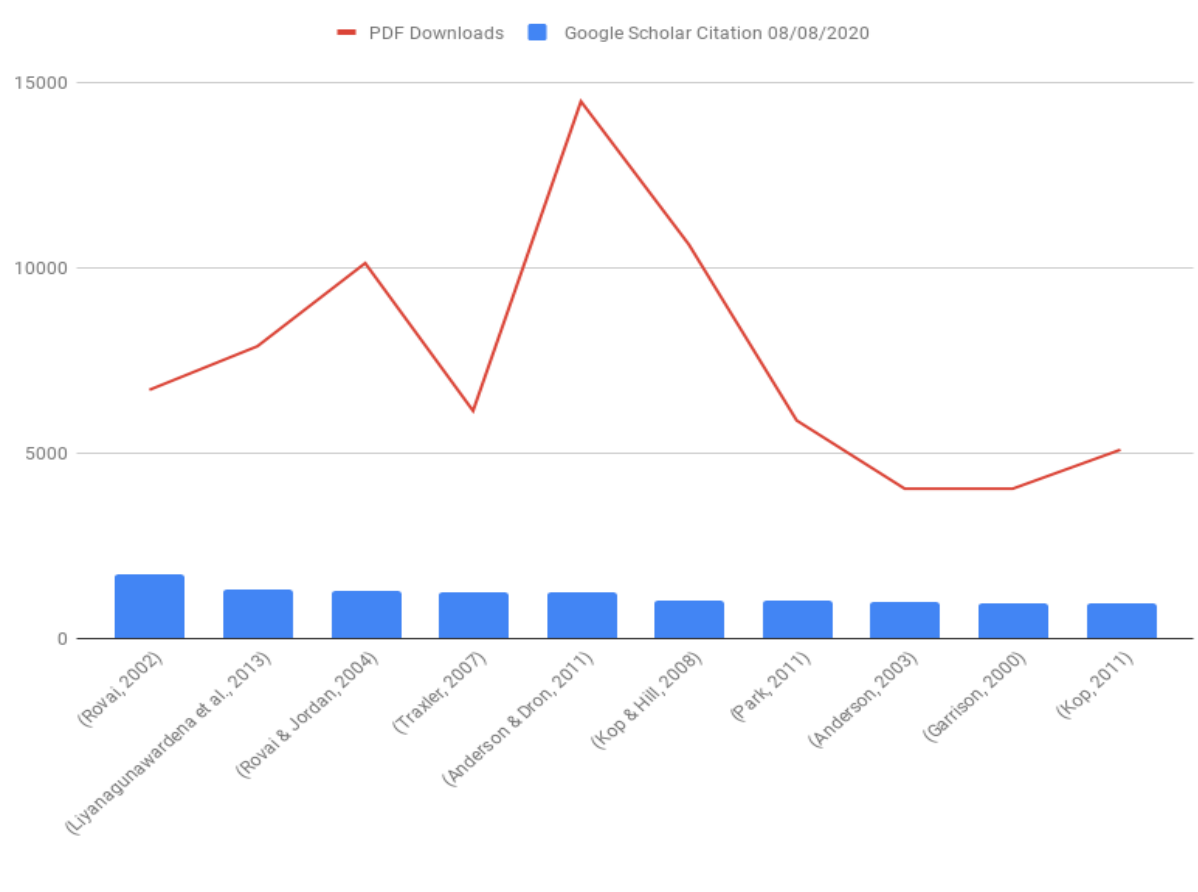
PDF Downloads and Google Scholar Citation Metrics of the Top 10 IRRODL Articles